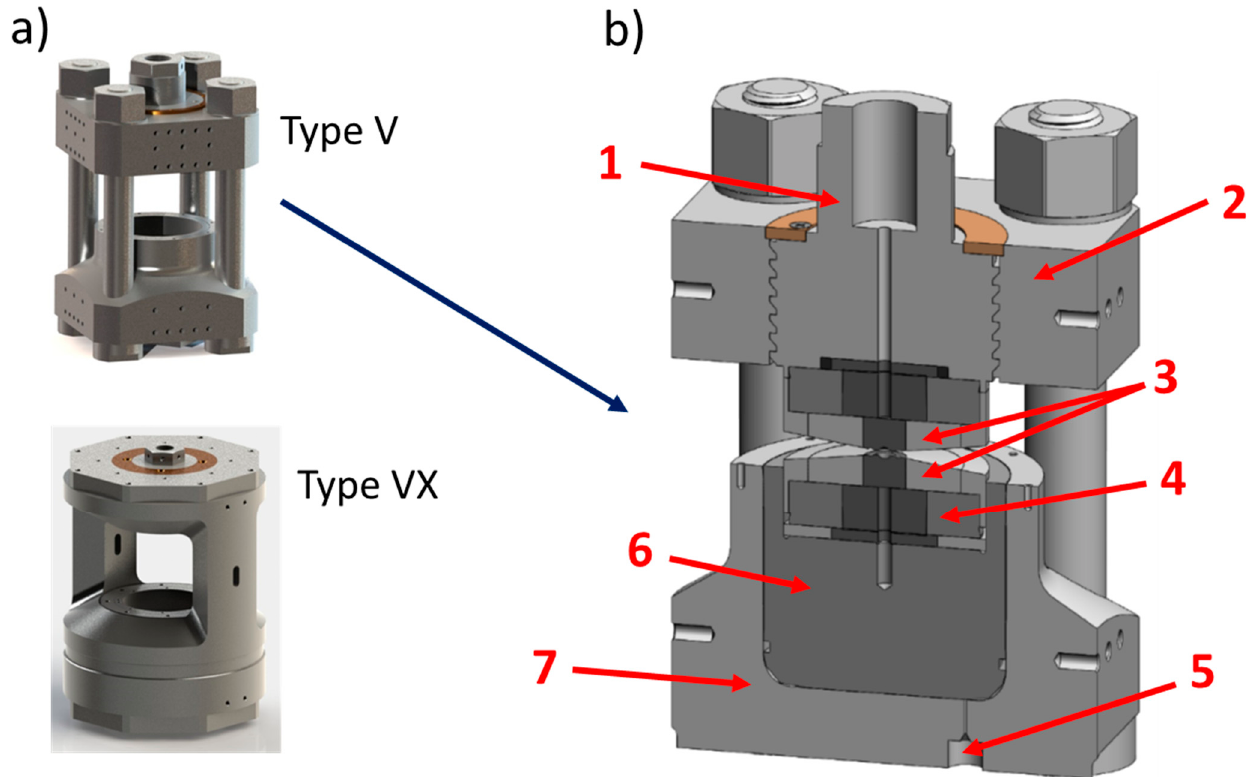
Figure 4. ( a ) The two types of Paris–Edinburgh (PE) press with 4 (type V) and 2 columns (type VX). ( b ) Cross-section of the V3 PE press: (1) breech, (2) top platen, (3) anvils, (4) seat, (5) hydraulic fluid inlet, (6) hydraulic piston, (7) ram.